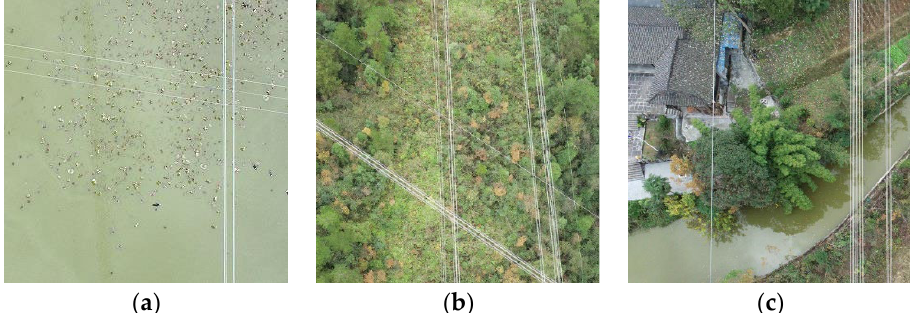
Figure 2. Examples of power line images with different IC. ( a ) Low IC; ( b ) Medium IC; ( c ) High IC.